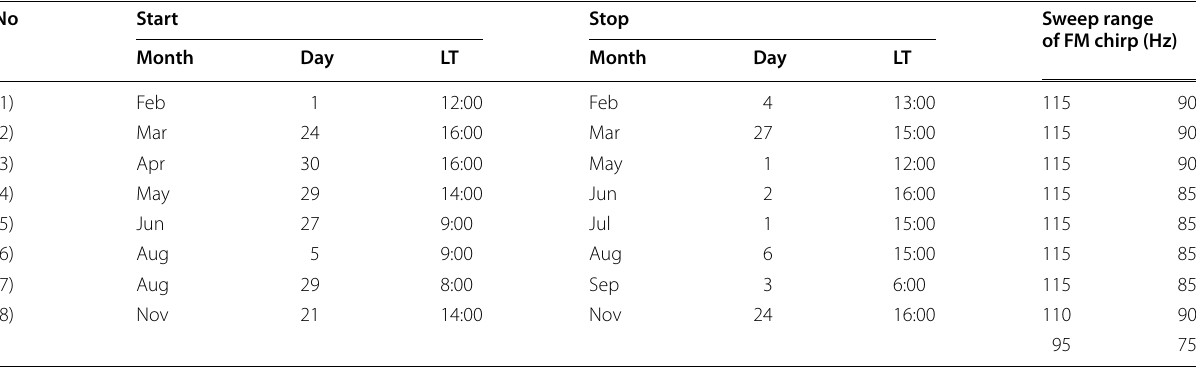
Table 4 Observation periods of EAR–RASS in